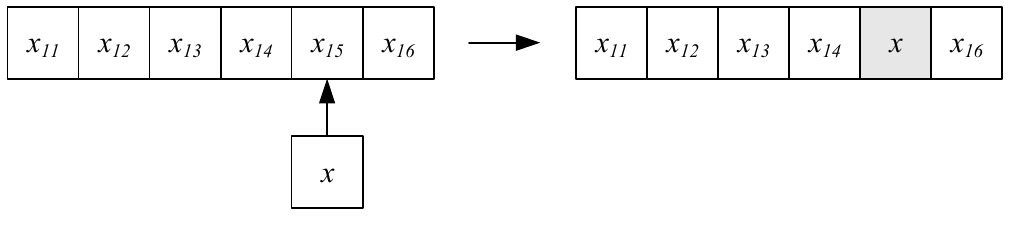
Figure 8. Mutation operation.